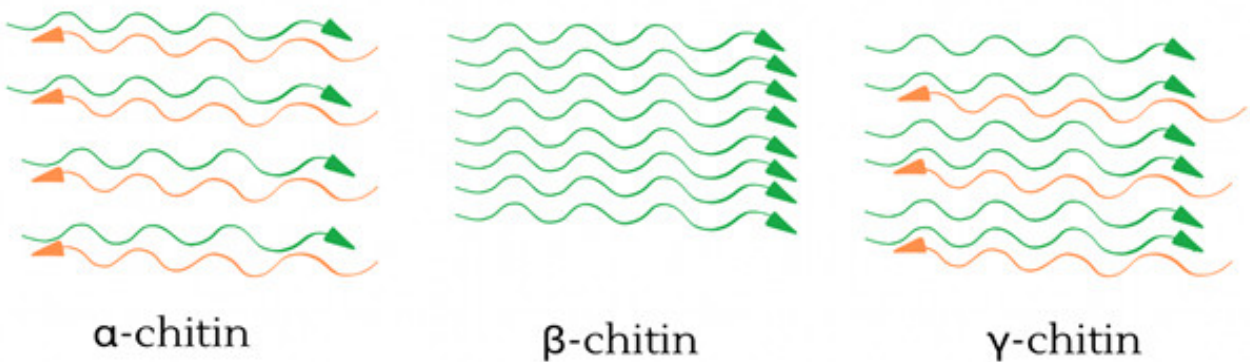
Figure 3. Visualization of antiparallel piles of chains found in α and γ chitin versus parallel ones found in ß-chitin.